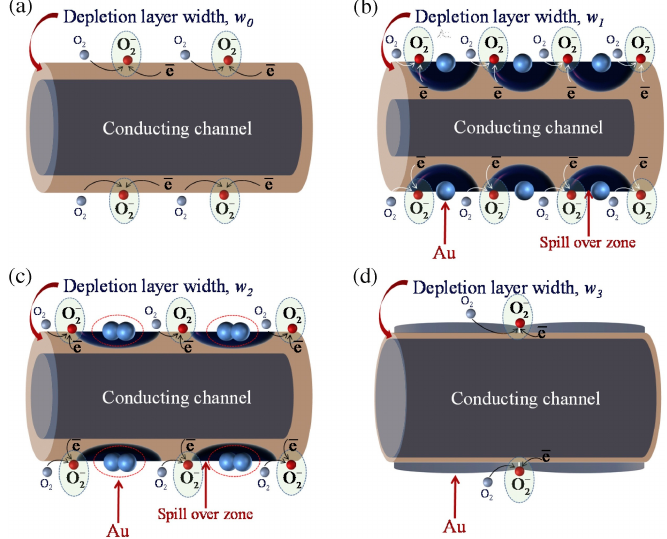
Figure 63. Schematic diagrams of depletion layer width resulting in sensor response of ZnO nanostructures sensor divided in case of ( a ) without Au ( b ) with Au ( c ) with large amount of Au and ( d ) with exceedingly coated Au amount. Reproduced with permission from [88]. Table 4. Ethanol sensing results of pure ZnO and Au NPs decorated ZnO under different mearsurement conditions. Room Temperature Material Condition ZnO ZnO:Au NPs Dark No response No response UV Low response High response